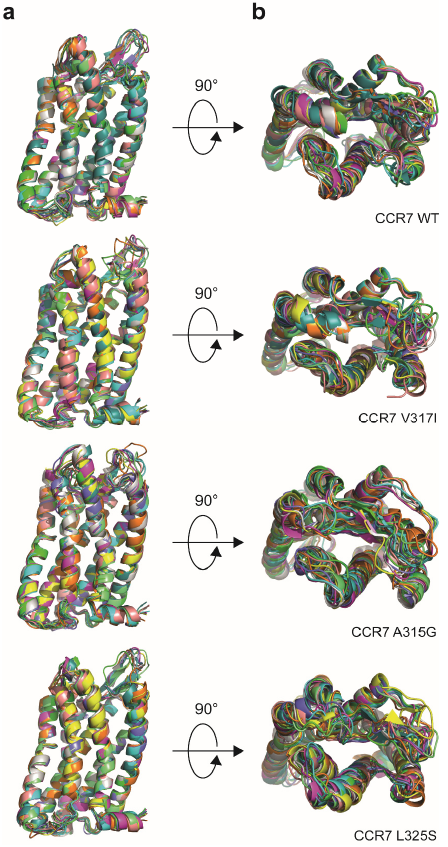
Figure 6. Receptor modelling reveals more flexibility for the extracellular loops in the CCR7 dimerisation-defective mutants. The sequences of the four CCR7 variants were subjected to protein structure flexibility modelling using CABS-flex 2.0. Ten possible receptor models for each CCR7 variant were colour-coded and overlayed: ( a ) receptor side views and ( b ) top views are shown.